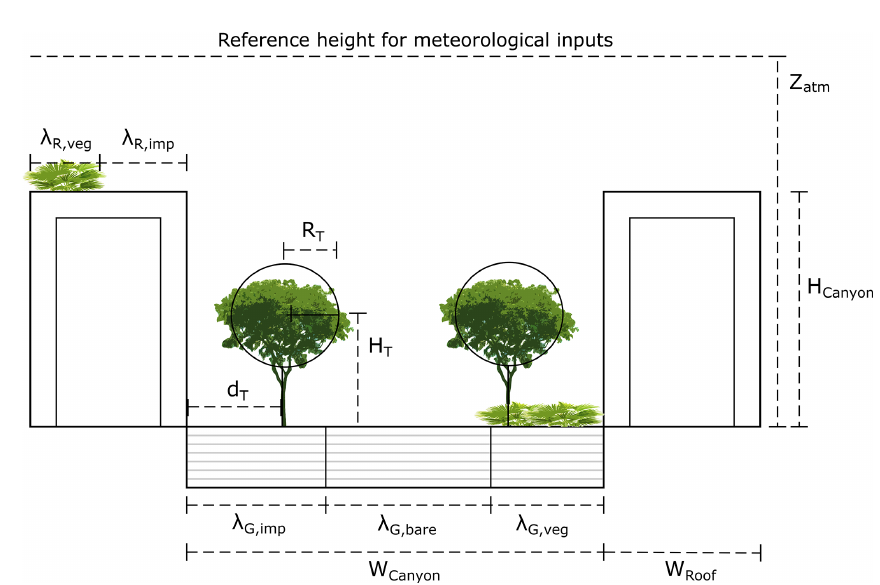
Figure 1. Geometric set-up of UT&C. Z atm is the reference height for meteorological input data, H Canyon the mean building height, W Canyon the mean width of the urban canyon, and W Roof the mean roof width. The ground is partitioned into impervious ( λ G,imp ), bare ( λ G,bare ), and vegetated ( λ G,veg ) fractions. The roof is partitioned into impervious ( λ R,imp ) and vegetated ( λ R,veg ) fractions. The location and size of urban trees is specified by the tree height ( H T ), tree radius ( R T ), and tree distance to wall ( d T ).